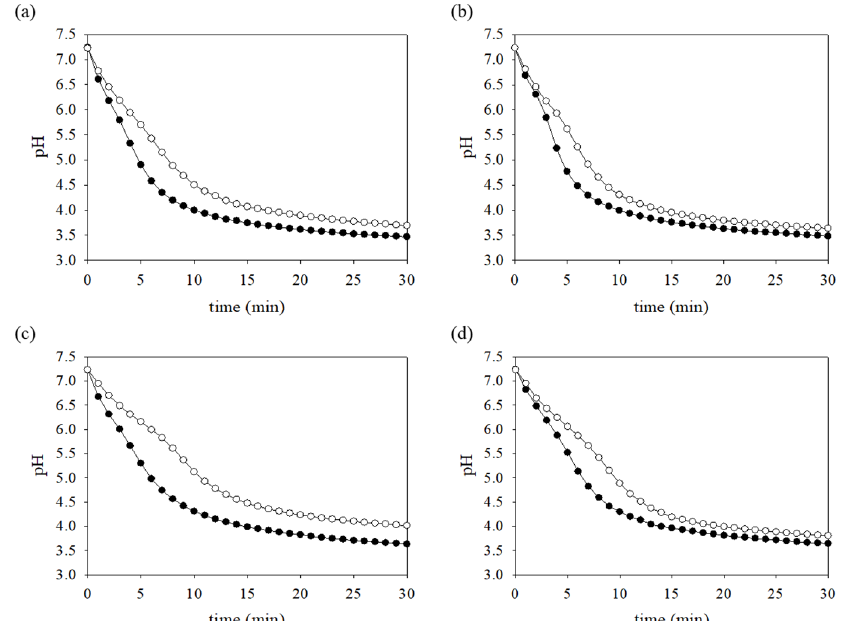
Figure 7. pH drop assays. S. mutans wild-type and FR strains were grown to mid-exponential phase in BHI medium supplemented with 20 mM glucose. The cultures were subjected to pH drop assays as described in the Materials and Methods. The assay was initiated by the addition of 50 mM ( a ) glucose, ( b ) sucrose, ( c ) mannose, or ( d ) fructose. The change in the pH was monitored at 1-min intervals for 30 min. The data represent the averages of results of three independent experiments. The symbols (closed and open circles) indicate S. mutans wild-type and FR strains, respectively.